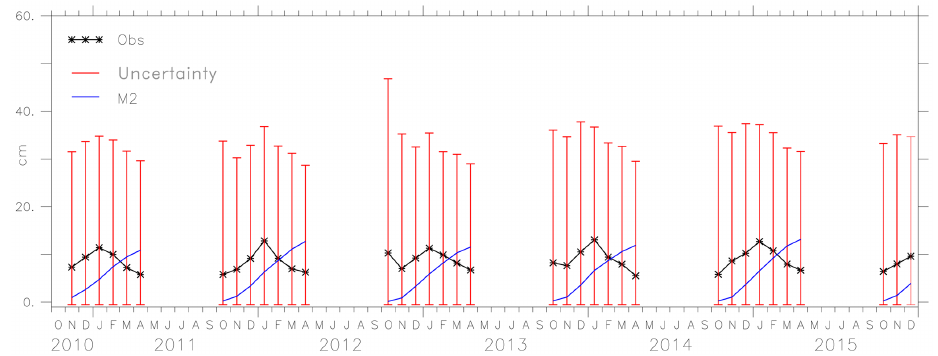
Figure 19. The freeboard from CryoSat-2, uncertainty in the observation and the model M2.